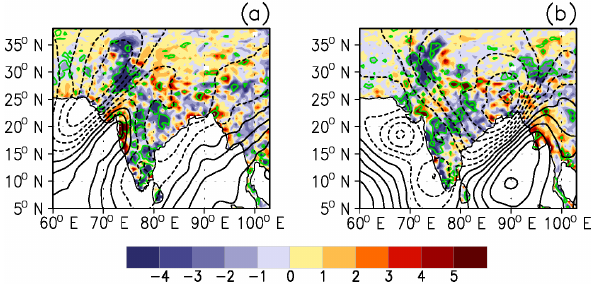
Figure 6. (a) Difference (PLC–HLC experiment) in climatologi- cal mean seasonal rainfall (in cm; 1982–2008) shown in shaded color. (b) Same as in (a) but for PLCS–HLCS experiments. Dashed (solid) black contours show the decrease (increase) in velocity po- tential analog (or the divergent component) of vertically integrated moisture flux q V (from surface–300hPa). The contour interval is in 1 × 10 6 kgs − 1 . Green contour shows differences significant at the 90% confidence